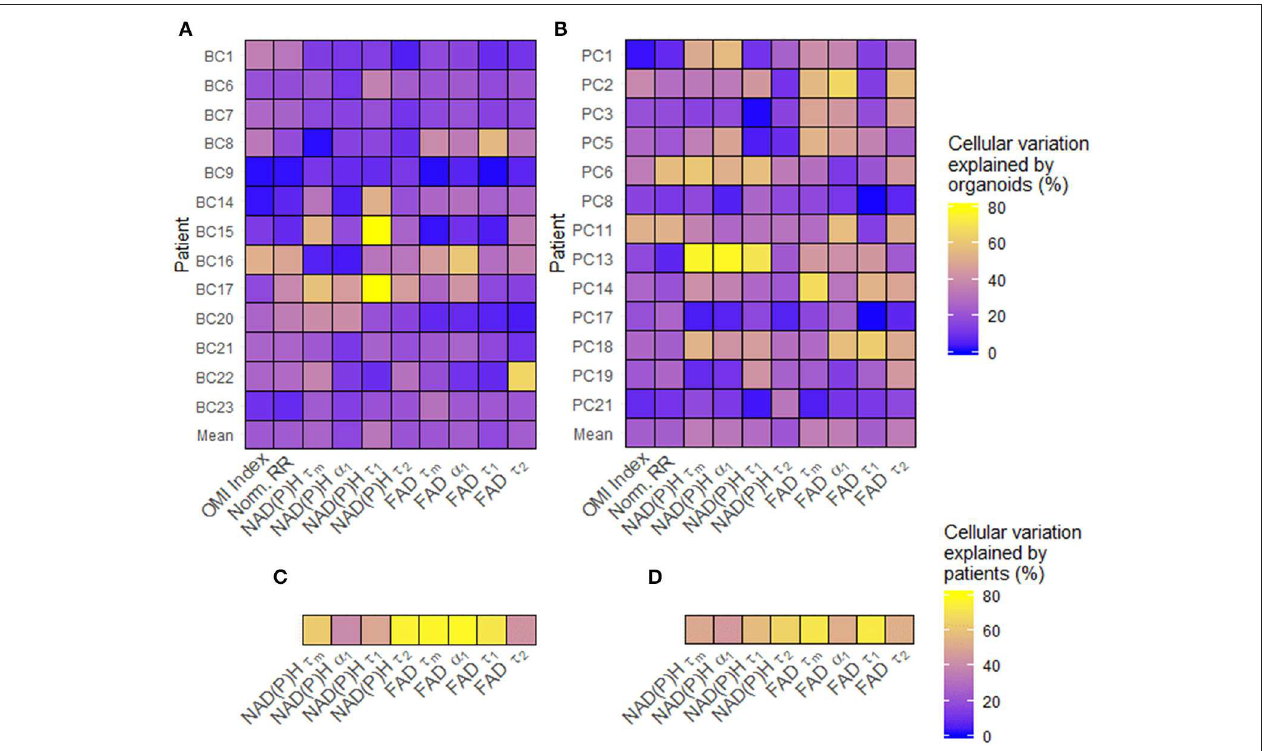
FIGURE 2 | Sources of baseline metabolic variability in patient-derived organoid cells. (A) The percentage of total metabolic variation among each breast cancer patient’s cells which can be explained by variation at the organoid level for each variable. (B) The percentage of total metabolic variation among each pancreatic patient’s cells which can be explained by variation at the organoid level for each variable. (C) The percentage of total metabolic variation among cells from all breast cancer patients which can be explained by variation between patients for each variable. (D) The percentage of total metabolic variation among cells from all pancreatic patients which can be explained by variation between patients for each variable. Untreated organoid cells from the first measurement time point were included in this analysis.